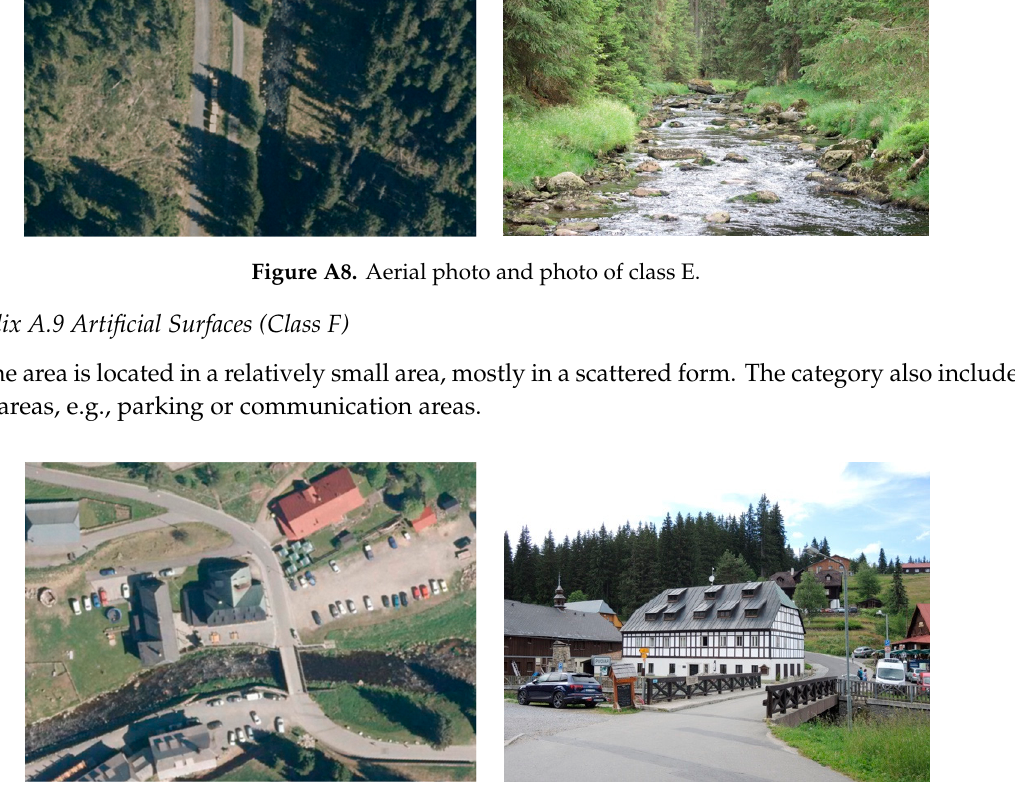
Table A1. Accuracy Assessment Matrix SVM—Combination 5.